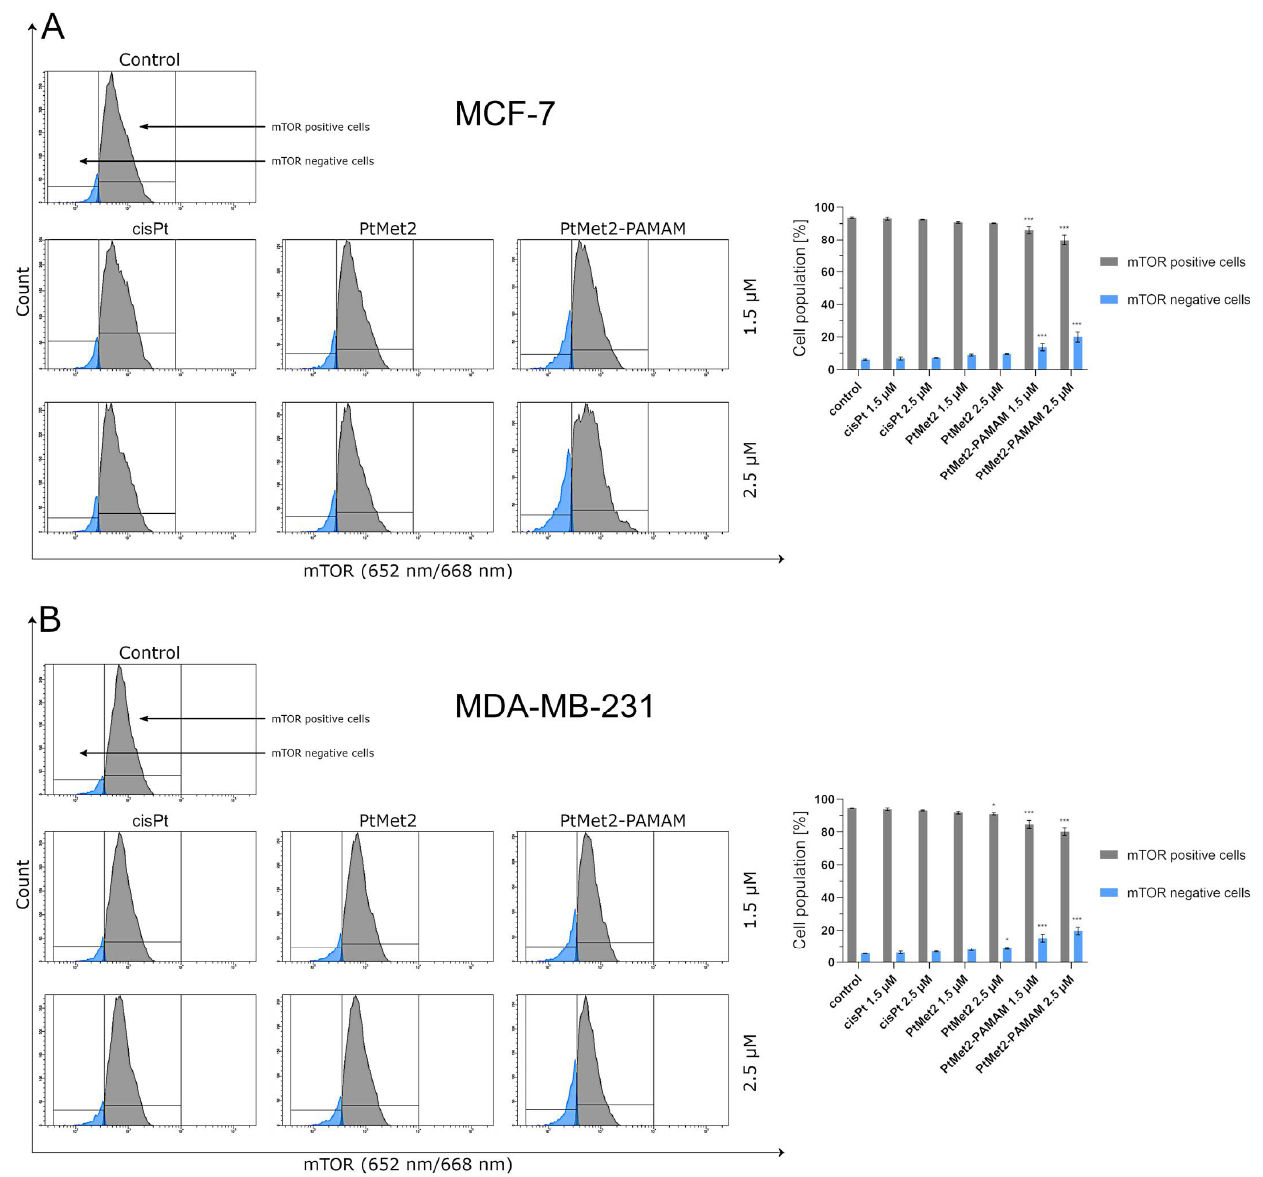
Figure 14. Anti-mTOR antibody flow cytometric analysis of MCF-7 ( A ) and MDA-MB-231 breast cancer cells ( B ) (blue color) compared to a negative control cell (gray color) after 24 h of incubation with PtMet2, PtMet2–PAMAM, and cisplatin (1.5 μM and 2.5 μM). Mean percentage values from three independent experiments ( n = 3) done in duplicate are presented. * p < 0.05 vs. control group, *** p < 0.001 vs. control group.